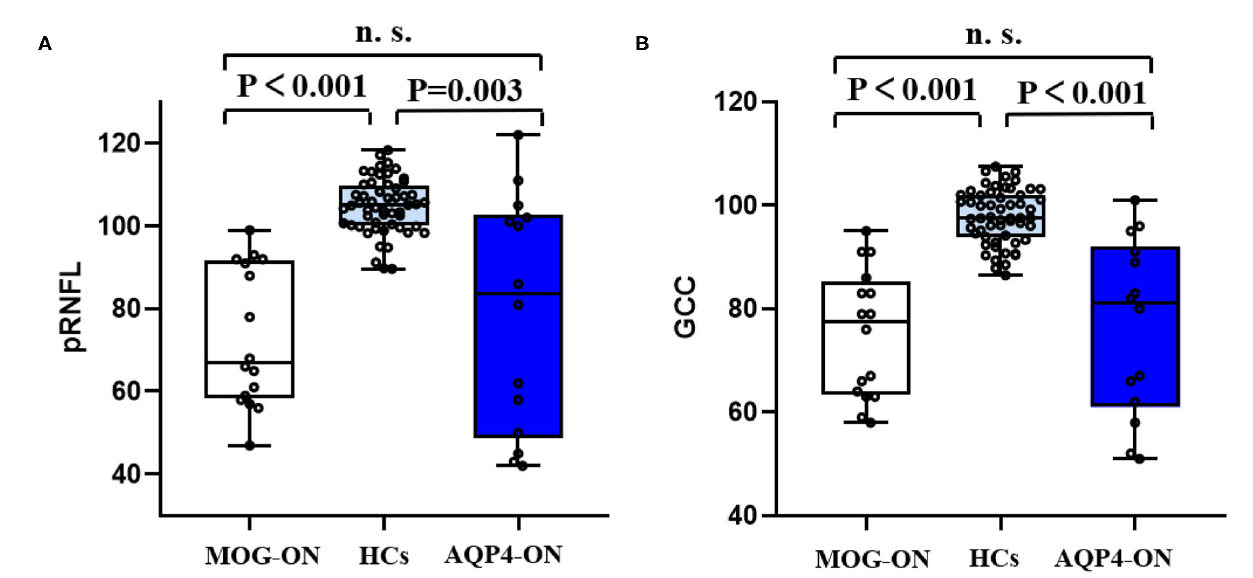
FIGURE 5 | OCT results in patients and HCs. Boxplot of V1 (A) and brain volume (B) in MOG-ON (left, white), HCs (middle, light blue), and AQP4-ON (right, dark blue). pRNFL, peripapillary retinal nerve fiber layer thickness; GCC, retinal ganglion cell complex; HC, healthy control; MOG-ON, optic neuritis patients with MOG antibody; AQP4-ON, NMOSD patients with AQP4 antibody positive and a history of ON; OR, optic neuritis.